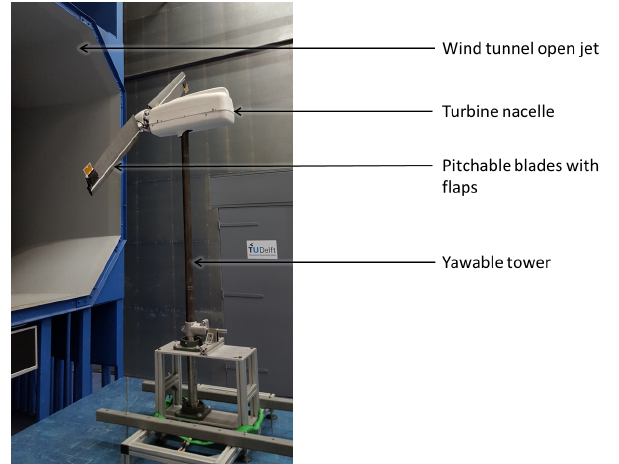
Figure 10. Variation of flutter speed with flap inertia. Figure 11. Photograph of the assembled turbine with pitch and flap